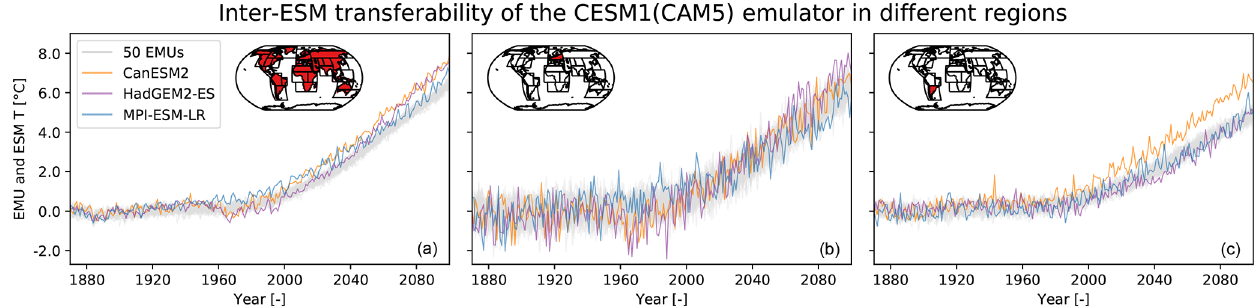
Figure 6. Time series of 50 emulations (EMUs) from the CESM1(CAM5) emulator (light gray) overlaid with runs from the three other example ESMs for three regions: global land (a) , CEU (b) , and SSA (c) .